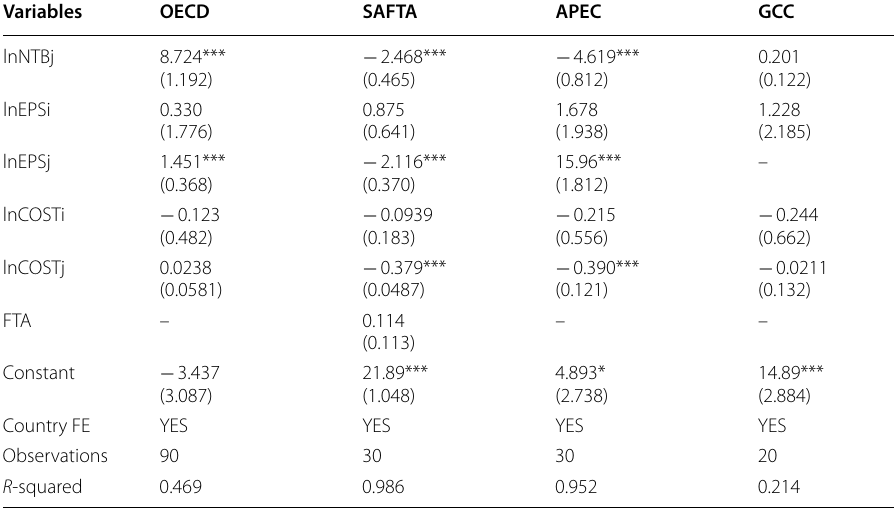
Table 9 Regression results, robustness checks; dependent variable: